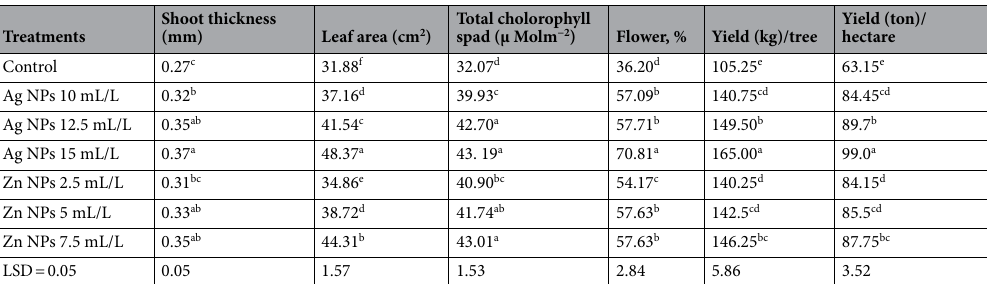
Table 1. Influence of spraying Ag and Zn NPs on shoot thickness, leaf area, total chlorophyll, flower percentage, and yield of “Florida prince” peach cultivar during 2020. *Means not sharing the same letter(s) within each column, significantly different at 0.05 level of probability.